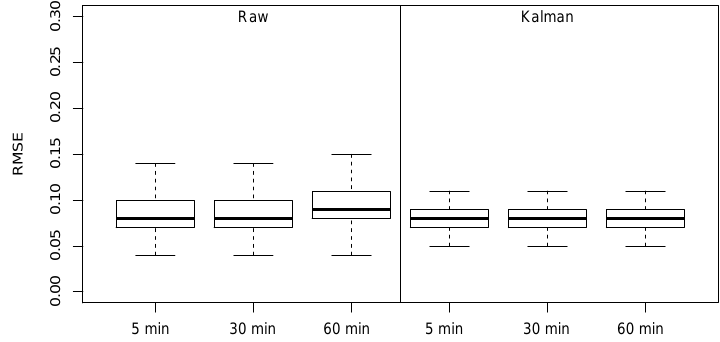
Figure 12. Performance boxplots with clustered segments and 4000 sample size.